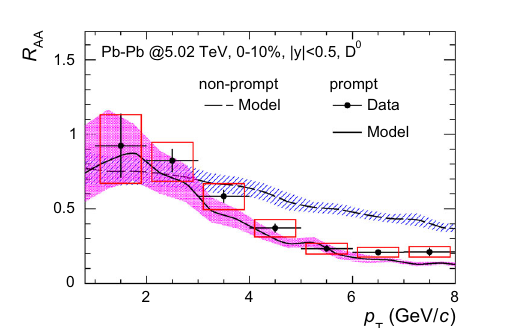
suppression behavior is found for D 0 from B -hadron decays (dashed curve), reflecting a weaker in-medium energy loss effect of bottom quark ( m b = 4 . 75 GeV), which has larger mass with respect to that of charm quark ( m c = 1 . 5 GeV). We note that the future measurements performed for the non- prompt D 0 R AA and v 2 , are powerful in nailing down the varying ranges of the model parameters (see Sect. 4), which will largely improve and extend the current understanding of the in-medium